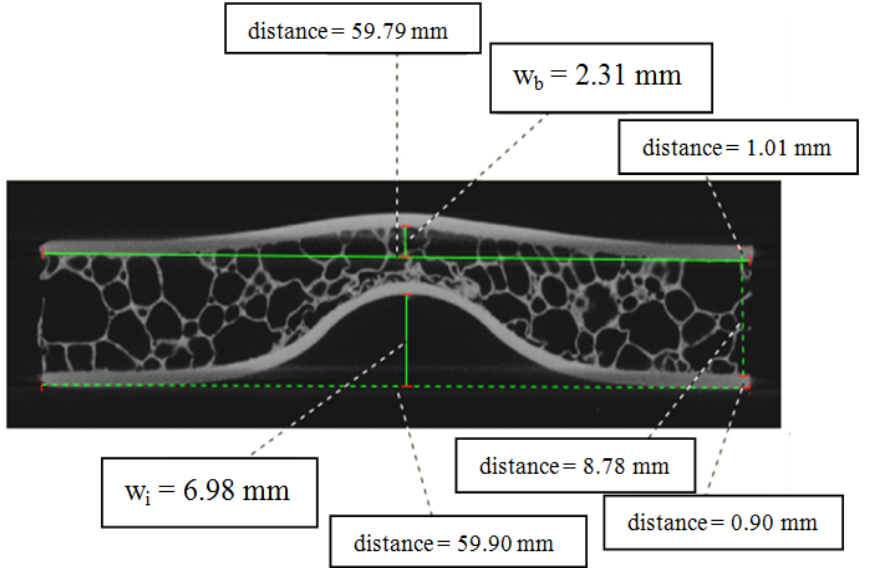
of the core. b and w carried out on the CT image. i b